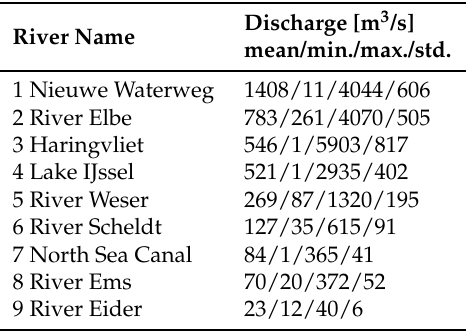
Table 1. Freshwater sources in the current setup based on daily observed